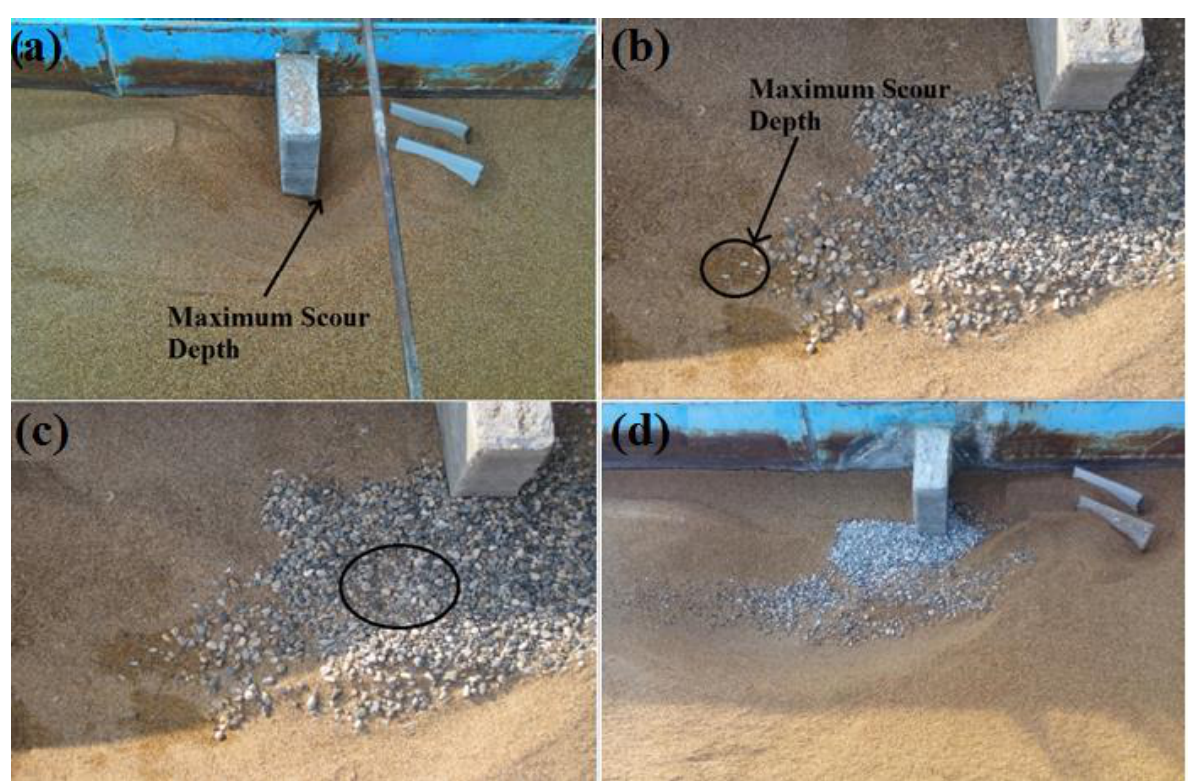
Figure 6. Maximum scour depth location and erosion of riprap stones around L V25 in case of sub- merged vane and riprap. ( a ) 𝑇 2 ; ( b ) 𝑇 3 ; ( c ) 𝑇 3 ; ( d ) 𝑇 4 (flow from right to left). submerged vane and riprap. ( a ) T 2 ; ( b ) T 3 ; ( c ) T 3 ; ( d ) T 4 (flow from right to